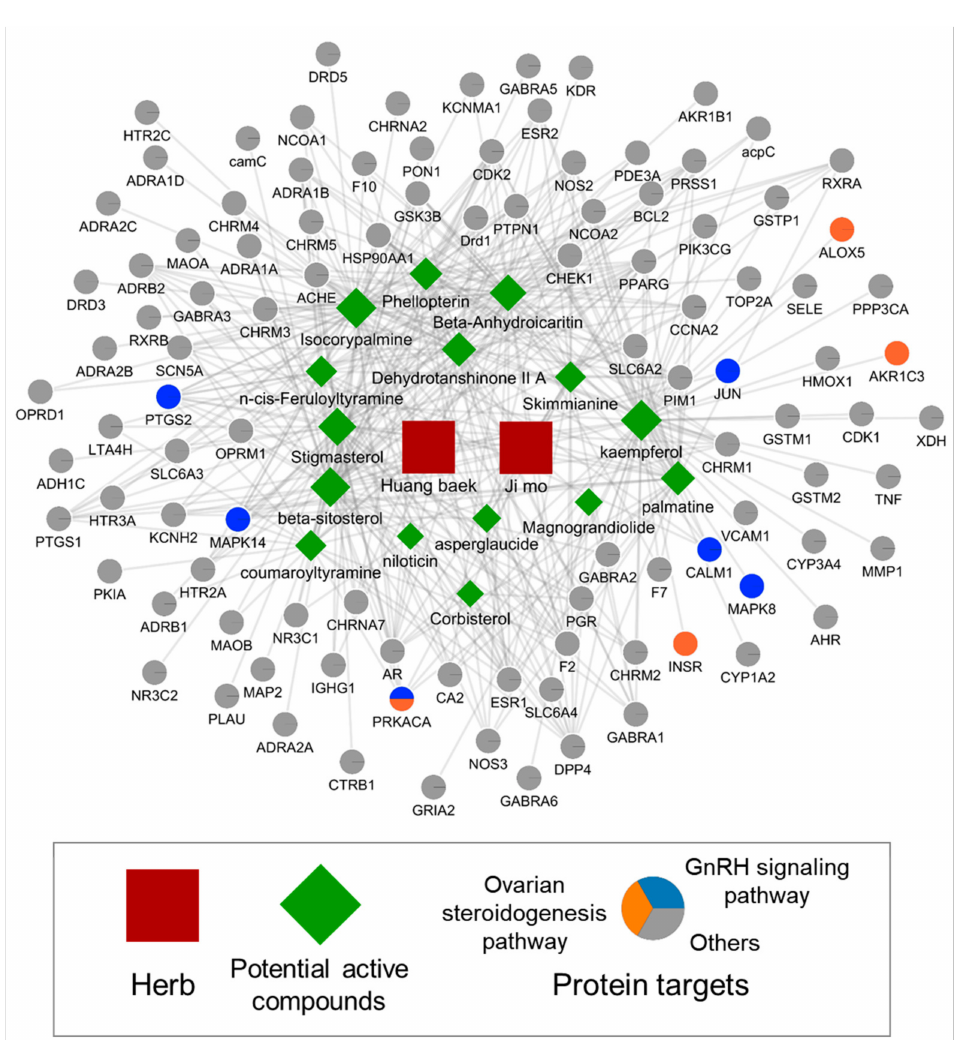
Figure 8. Compound–target network of APE. The targets genes of the GnRH signaling and ovarian steroidogenesis pathways are presented by colored nodes. Genes directly associated with PP are bordered in the network. The size of each node is proportional to its interaction